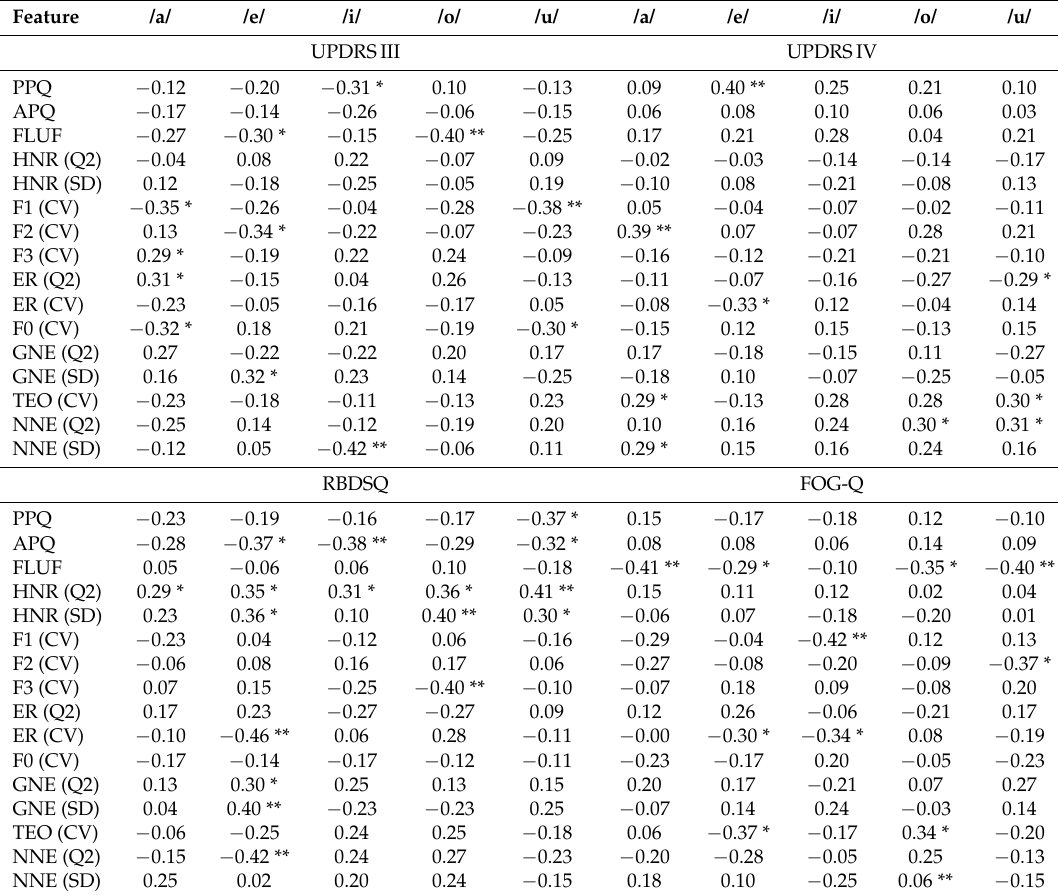
Table 4. Spearman’s correlation coefficients between ∆ of acoustic features and ∆ of clinical